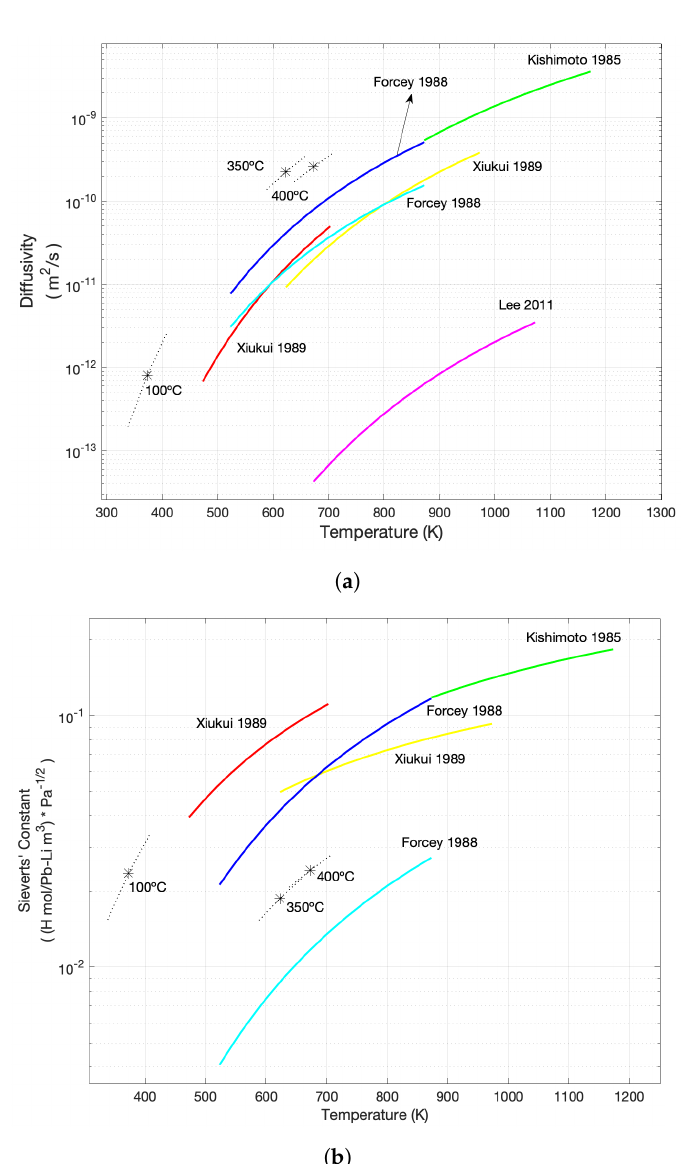
Figure 9. Comparison between literature functions of D 316L and S 316L (coloured), and those deter- D D 2 mined by the curve-matching strategy (in black , vide Table 2). As each experiment provided a set of dissolution parameters, the general behaviour of the Arrhenius Law around the temperature set for the experiment ( asterisk markers) is displayed by curve extensions ( dotted lines). ( a ) Comparison between literature functions of diffusivity for deuterium in 316L steel [12,14,44,45], and from set of dissolution parameters ( D ∞ and E d ) derived in this work. ( b ) Comparison between literature functions of Sieverts’ constant for deuterium in 316L steel [12,14,44], and from set of dissolution parameters ( S ∞ and E s ) derived in this